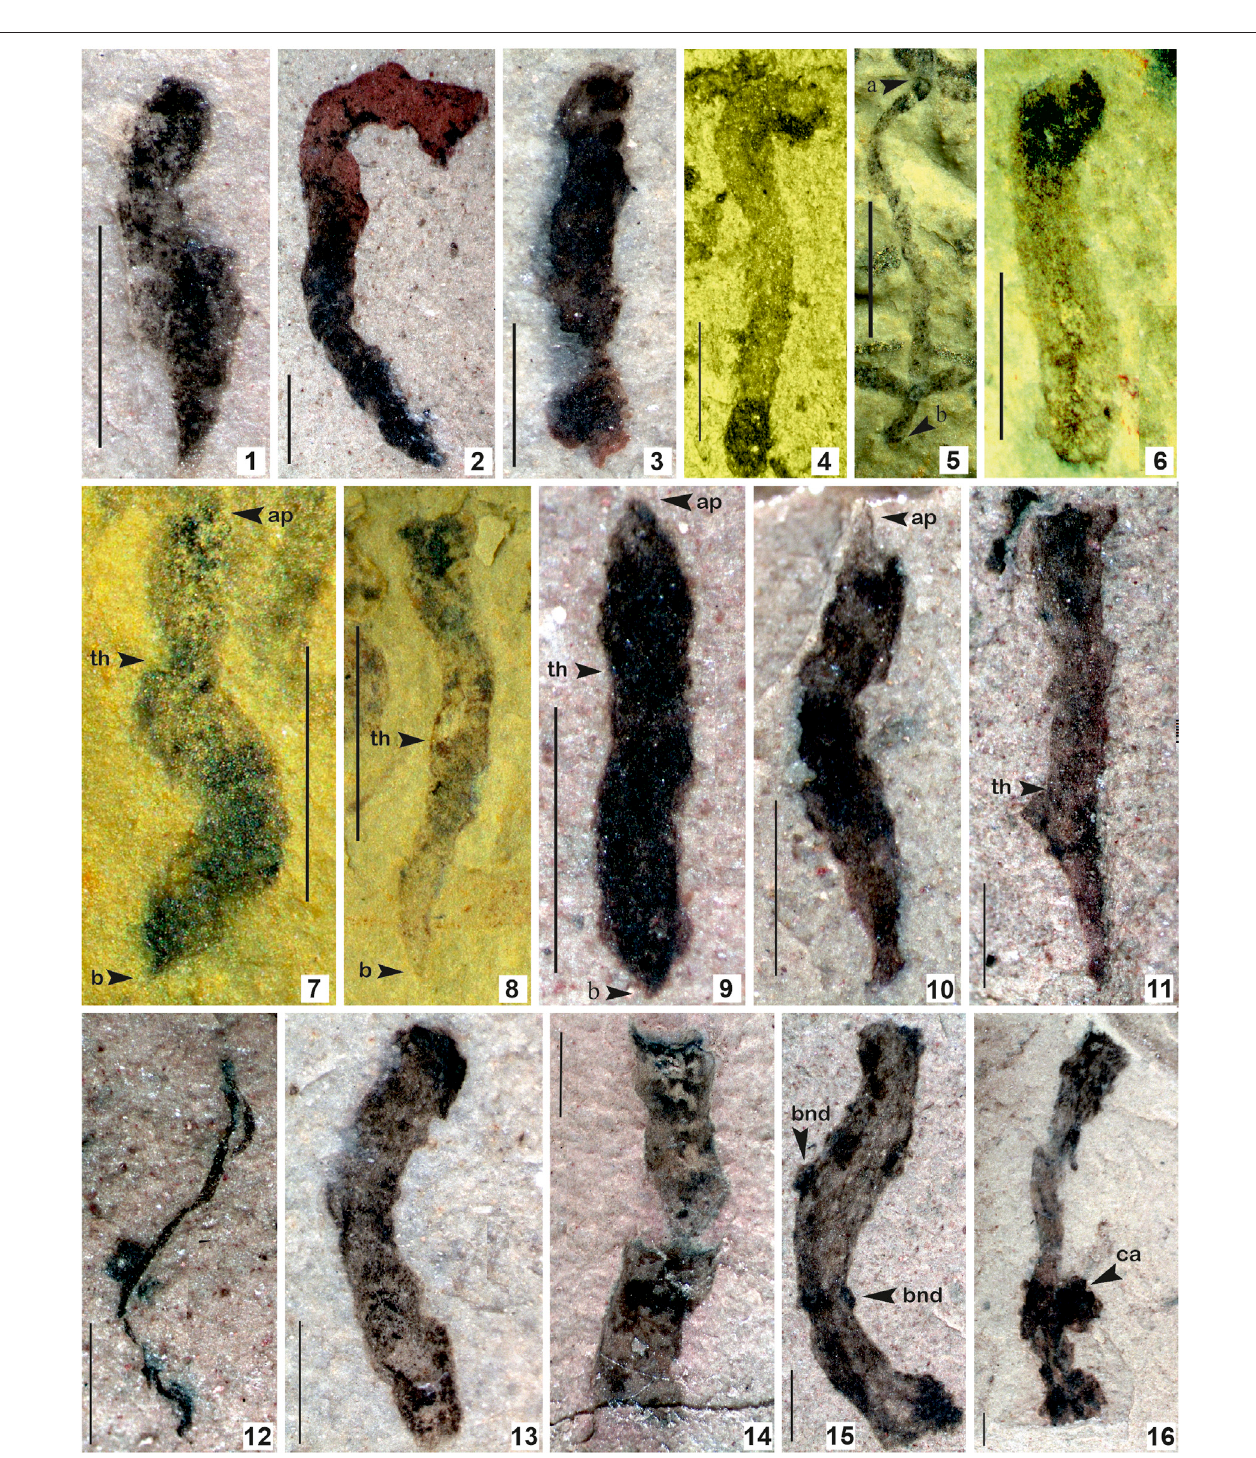
FIGURE 7 | 1 – 6 . Tuanshanzia fasciaria (Yan) Yan and Liu, 1997; 7 – 11 . Tuanshanzia lanceolata Yan, 1995; 12. Tyrasotaenia podolica Gnilovskaya, 1971; 13 – 16 . Unnamed ribbon-like fi lm comprised of small conical/circular projection on the surface. (Arrow indicates the prominent features: bnd. Branching node; ca. colonial aggregates;th.thallus)1.Specimenno.BSIP42040;2.Specimenno.BSIP42039;3.Specimensno.BSIP42041;4.Specimenno.BSIP39777;5.Specimenno.BSIP 39780; 6. Specimen no. BSIP 39769; 7. Specimen no. BSIP 39769; 8. Specimen no. BSIP 39782; 9. Specimen no. BSIP 42028; 10. Specimen no. BSIP 42036; 11. Specimen no. BSIP 42043; 12. Specimen no. BSIP 42025; 13. Specimen no. BSIP 42033b; 14. Specimen no. BSIP 42031; 15. Specimen no. BSIP 42045a; 16. Specimen no. BSIP 42044. Specimens 1 – 3, 9 – 16 from the Bendla Dongar section and 4 – 8 from the Surangi River section. Scale bar is 1.0 mm for each specimen.